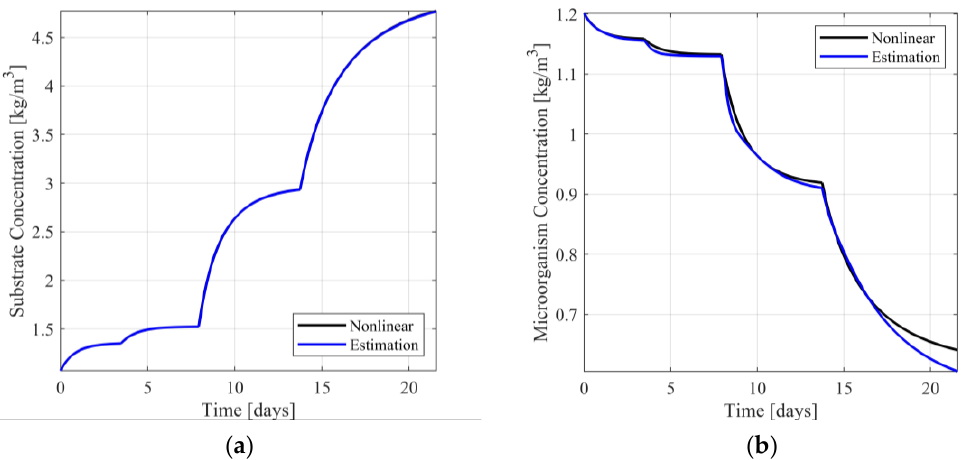
Figure 4. ( a ) Substrate concentration response/estimation; ( b ) Microorganism concentration re- sponse/estimation.